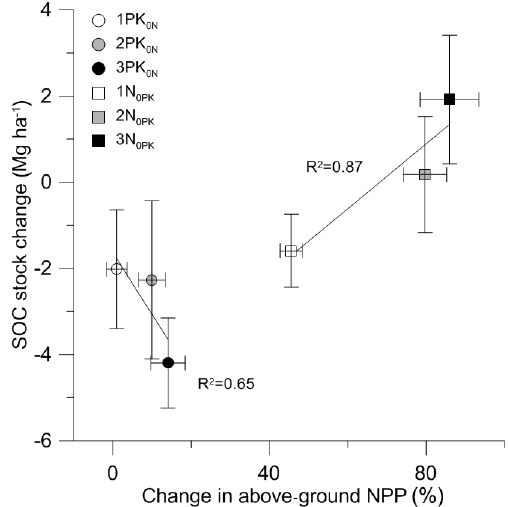
Figure 2. Correlation of average SOC stock differences between fertilised and unfertilised soils and average yield differences in fer- tilised and unfertilised soils with separate regression lines for the P- and N-fertilised regimes. Error bars indicate standard errors.